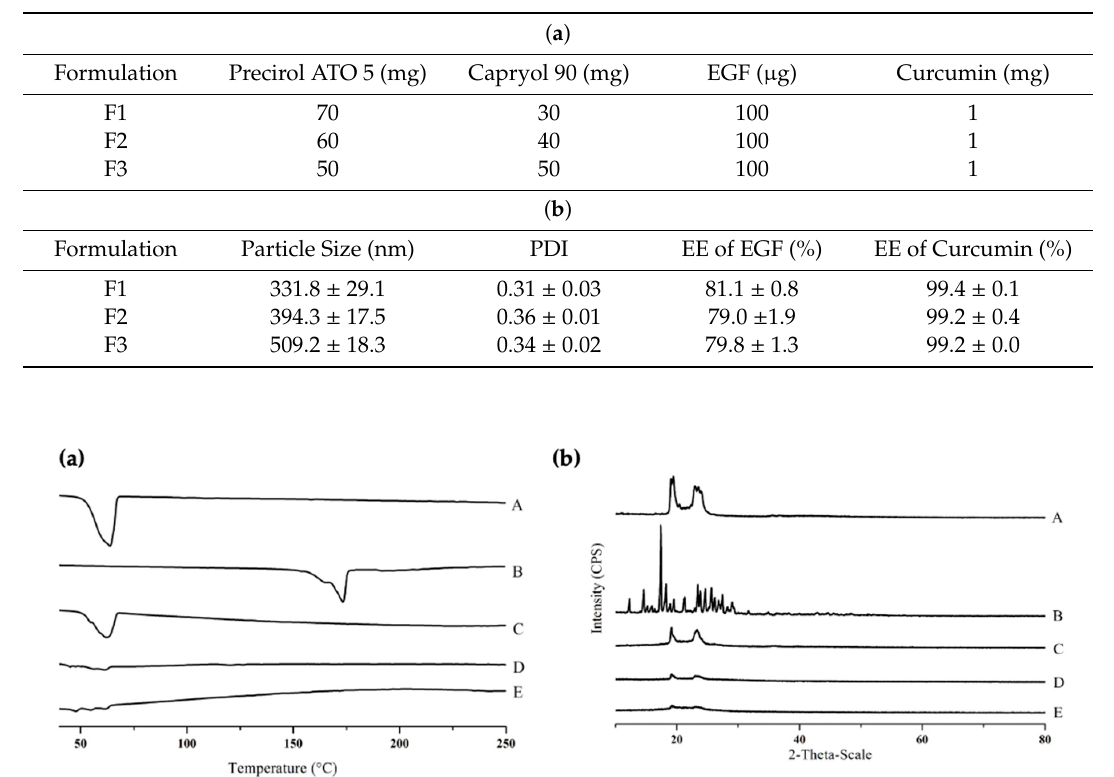
Table 1. ( a ) Composition of various formulations, ( b ) physicochemical properties of formulations according to the ratio of solid and liquid lipids. EGF, epidermal growth factor, PDI, polydispersity index, EE, encapsulation e ffi ciency.